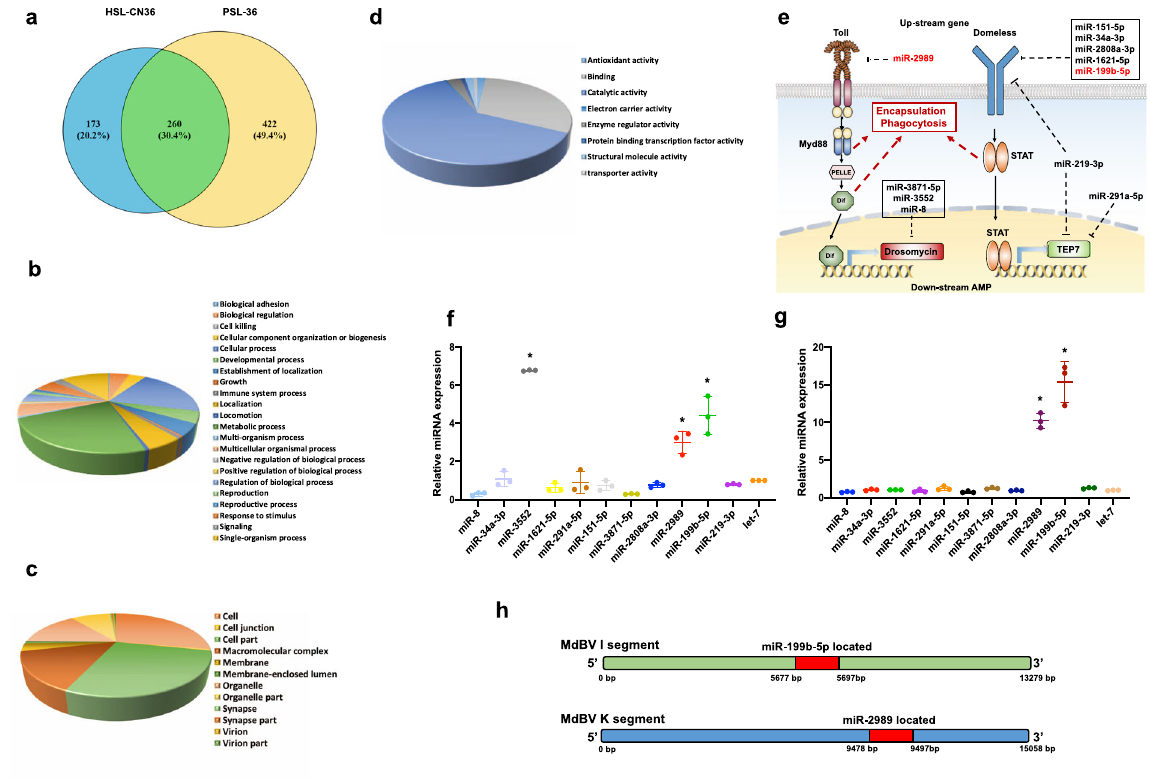
Fig. 1 Different miRNAs expression in parasitized and unparasitized S . litura . a miRNAs produced in unparasitized S. litura (HSL-CN) and S. manilae - parasitized S. litura (PSL-36; 36 h post-parasitism). Genes that may be affected by mature miRNAs expression in S. manilae -parasitized S. litura were identi fi ed by miRBase and classi fi ed according to their involved biological processes ( b ), cellular compartments ( c ), and molecular functions ( d ). e miRNAs produced in S. litura after S. manilae parasitism with gene targets predicted in the Toll and JAK/STAT pathways. f The expression levels of 11 predicted miRNAs were quanti fi ed by a stem-loop qPCR in S. litura third-instar larvae 48 h after S. manilae parasitism. The expression of let-7 miRNA serves as a positive control. g The expression levels of 11 predicted miRNAs were quanti fi ed using stem-loop qPCR in SL1A cells 48 h after SmBV infection, with let-7 miRNA as the positive control. A Ct value of 35 was set to be the cutoff for detection. h miR-199b-5p and miR-2989 are present on MdBV genome segments I and K. The red bars represent the locations of the two precursors. At least three repetitions were conducted for each group. p -value were calculated using Student ’ s t -test (* p <